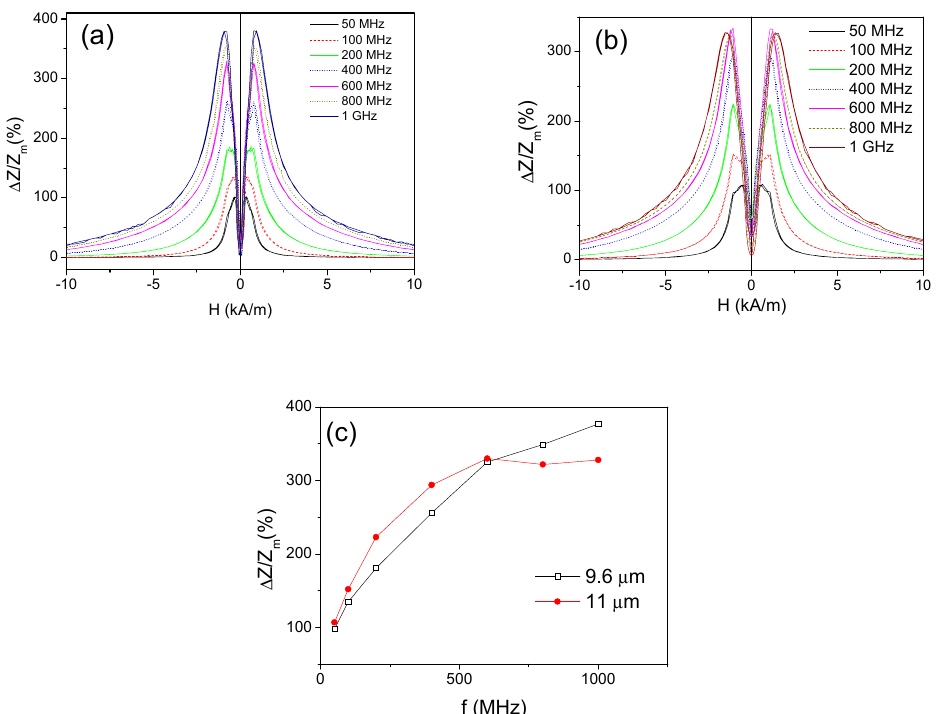
Figure 4. ∆ Z / Z ( H ) dependencies measured in as-prepared Fe 3.6 Co 71.3 Ni 0.2 B 13.4 Si 10.4 C 0.9 Mo 0.2 with d = 9.6 µ m ( a ) and 11 µ m ( b ) microwires and ∆ Z / Z m ( f ) dependence for both microwires ( c ).